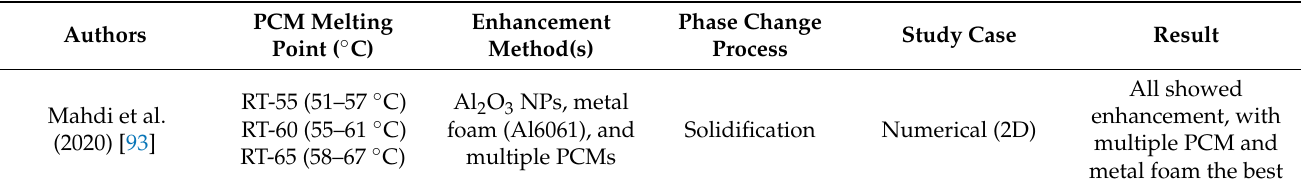
Table 5. PCM, NP type, and enhancements are described for the multiple PCM enhanced experiment. Phase change process, type of study, and a summary of study results are also